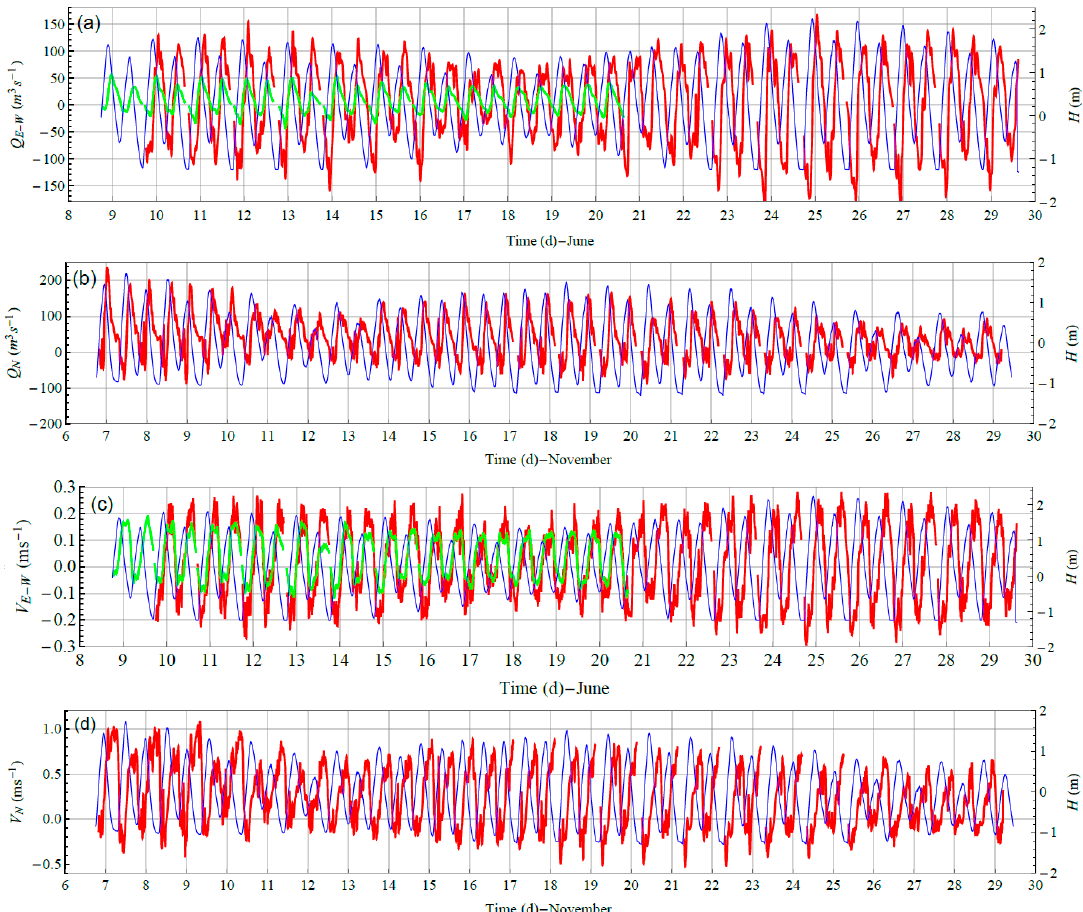
Figure 5. Temporal variations of ( a ) water level at the eastern branch (blue line), tidal discharge at the eastern branch (red line), and tidal discharge at the western branch (green line). ( b ) Water level at the northern branch (blue line) and tidal discharge at the northern branch (red line). ( c ) Water level at the eastern branch (blue line), tidal velocity at the eastern branch (red line), and tidal velocity at the western branch (green line). ( d ) Water level at the northern branch (blue line) and tidal velocity at the northern branch (red line). Positive discharge and velocity coincide with the seaward flow.